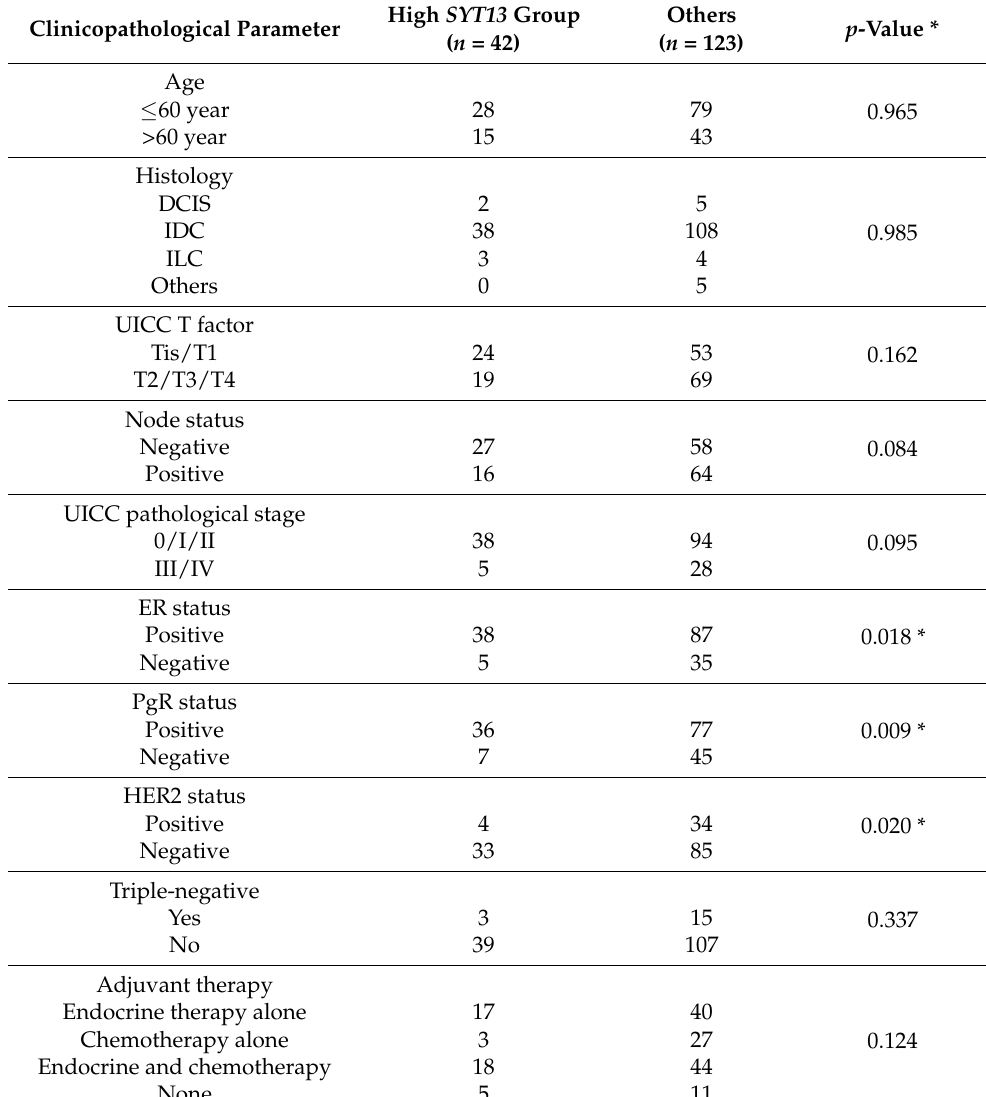
Table 3. Associations between SYT13 mRNA expression and clinicopathological characteristics of 165 patients with breast